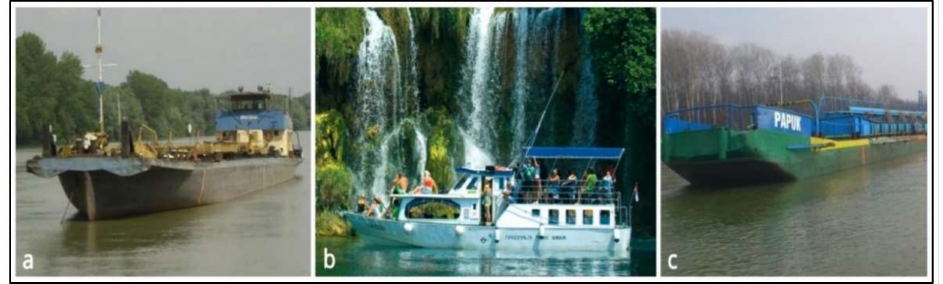
Figure 9. Selected ships in operation: ( a ) cargo ship “Opatovac” [65], ( b ) passenger ship “Trošenj” [66], and ( c ) dredger “Papuk” [67].